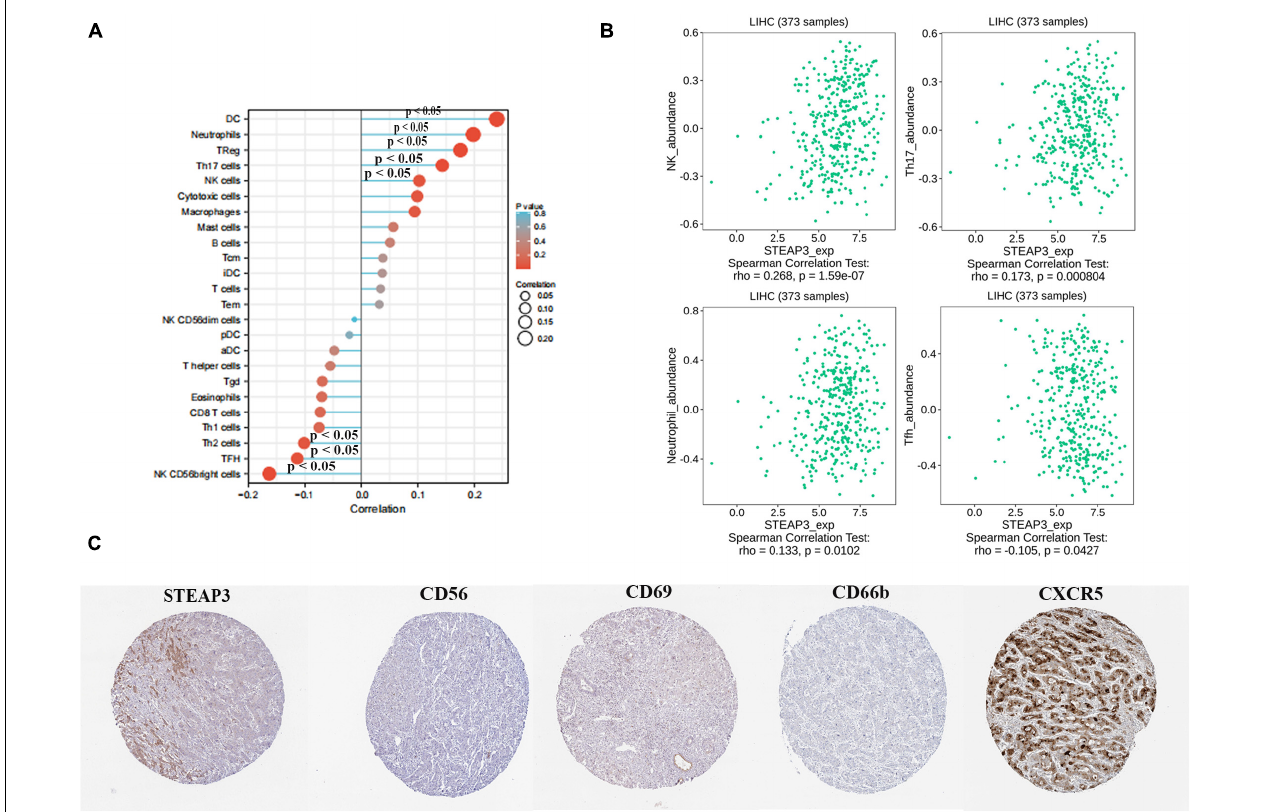
FIGURE 6 | Correlation between STEAP3 expression with immune infiltration level in LIHC. (A) The association between STEAP3 expression level and 24 types of immune cells in TCGA database. Absolute values of Spearman r were measured by the size of round dots. (B) The scatterplot showed the association between STEAP3 and abundance of tumor-infiltrating lymphocytes (TILs), including NK cells, Th17 cells, neutrophils and Tfh cells. (C) Tumor infiltration of NK cells, Th17 cells, neutrophils and Tfh cells in liver cancer. STEAP3 staining, CD56 (NK marker), CD66b (neutrophils marker) were not detected, and CD69 (Th17 marker) showed low staining, while CXCR5 (Tfh marker) showed high